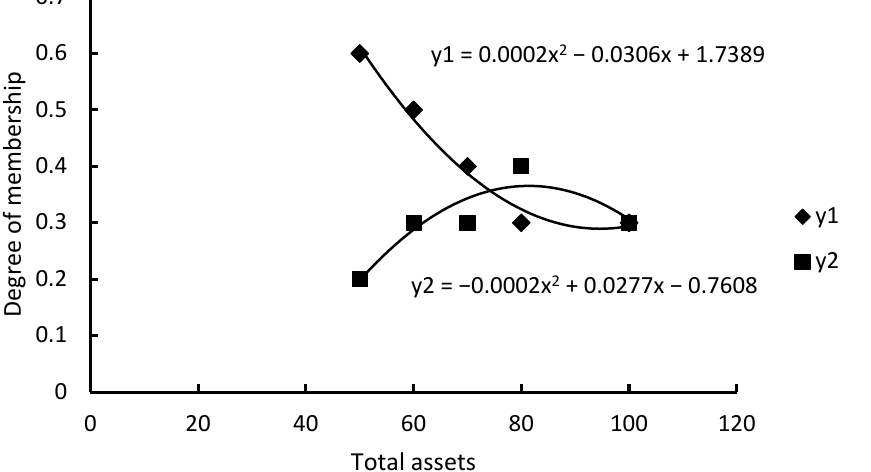
Figure A6. Single factor evaluation for the index of total assets (50–100 (inclusive) ten thousand yuan).